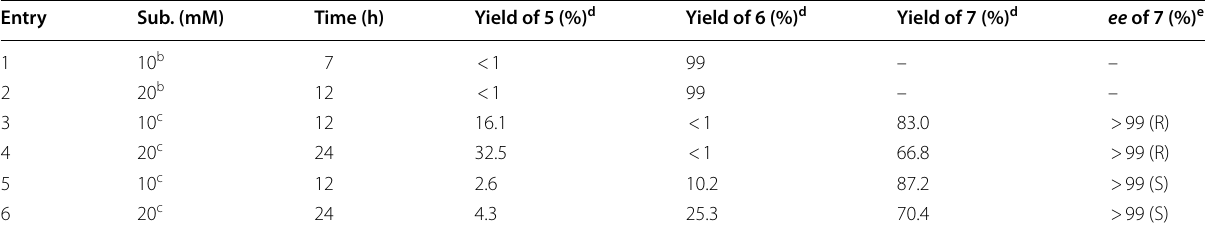
Table 1 Cascade biocatalysis for conversion of L-PA 1 to 2-HAP 6 and chiral phenylglycinol 7 with the mixture of lyophilized cell-free extract a